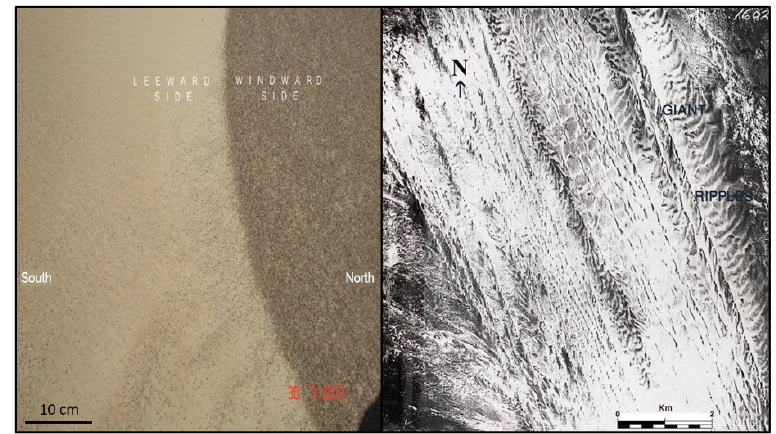
Figure 4. Giant ripples of Ghard Abu Moharik. ( Left ): Field photograph with dark-colored windward side and light-colored leeward side. ( Right) : Landsat TM image with rows of giant ripples in the central section of Ghard Abu Moharik. Source: [44].